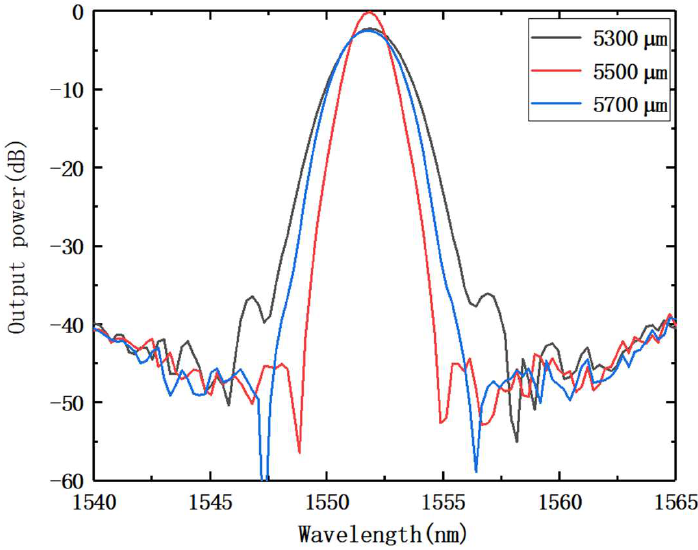
Figure 4. Transmission spectra under different FPR length.